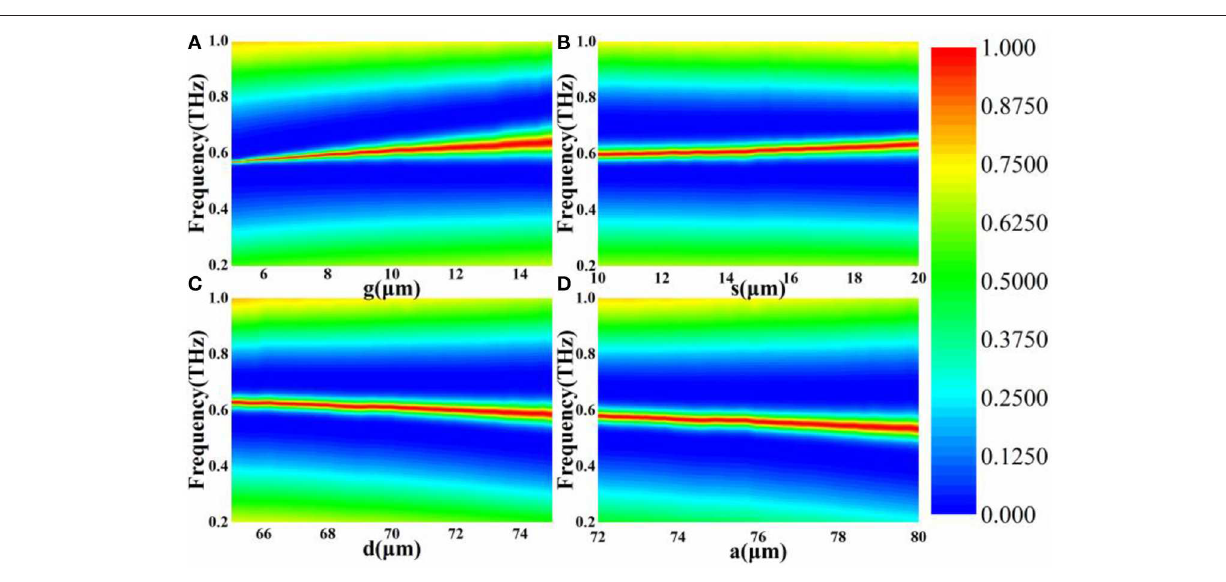
FIGURE 3 | Terahertz transmittance contour plot for various geometrical parameters values of our proposed CsPbBr 3 -QD-embedded metasurface (A) g , (B) s , (C) d , (D) a